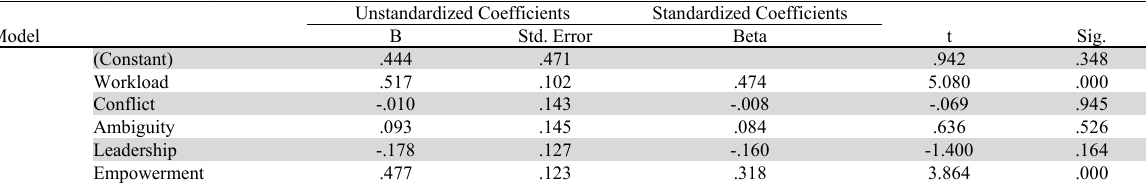
The summary of the regression analysis Model